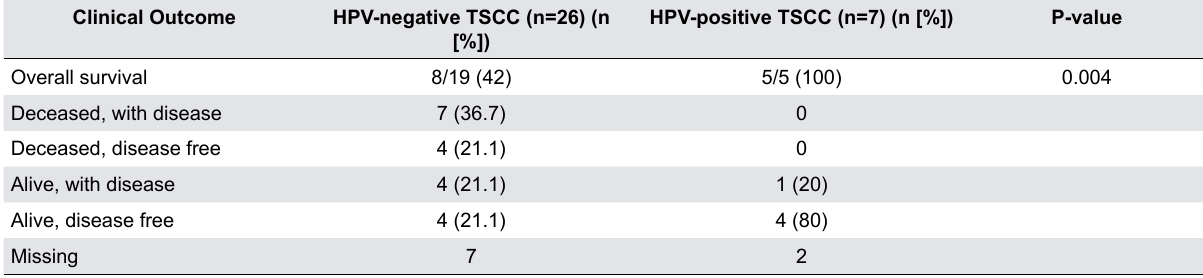
Figure 3- Kaplan-Meier overall survival curves according to HPV status in tonsillar squamous cell Table 4- Clinical outcomes for all patients with tonsillar squamous cell carcinoma